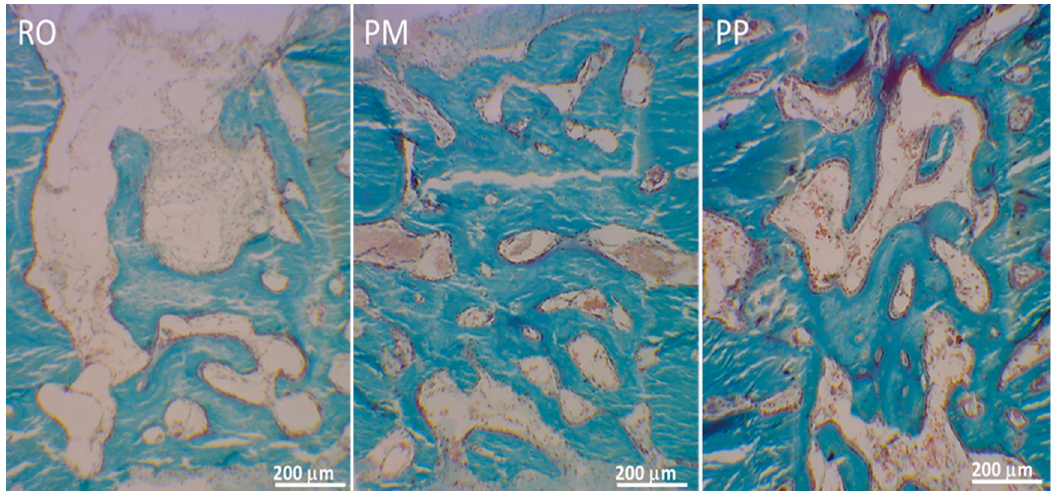
Figure 3. LM micrographs showing in three different osteotomies the newly formed bone during gap recovery.